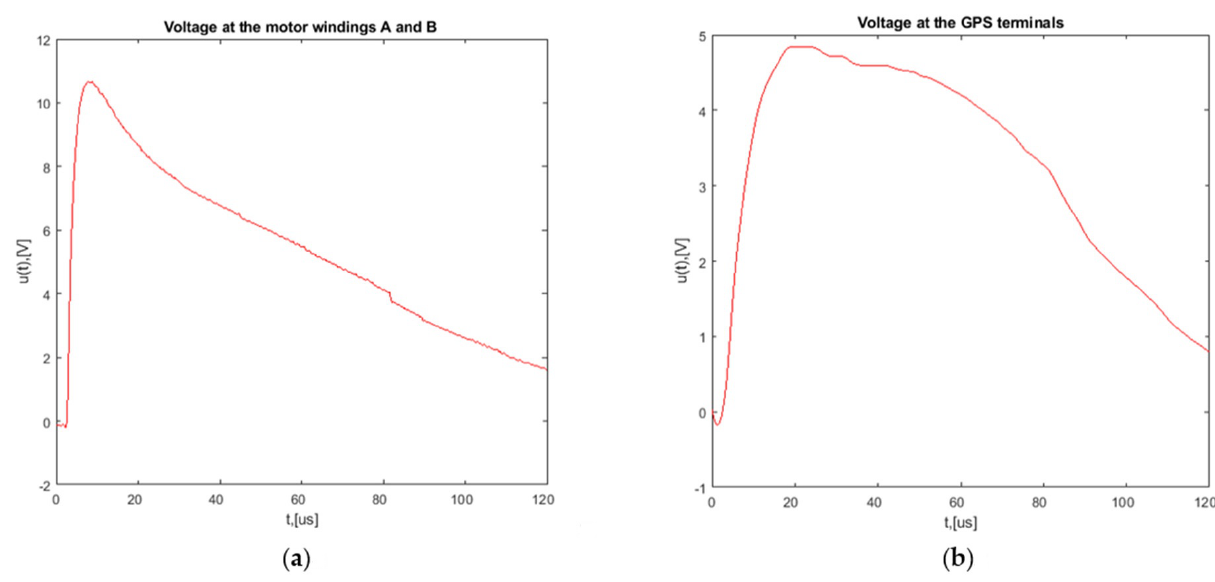
Figure 8. ( a ) Input—Voltage measured at the A and B pins of the first motor windings; ( b ) Output—Voltage measured at the terminals of the engine control system.